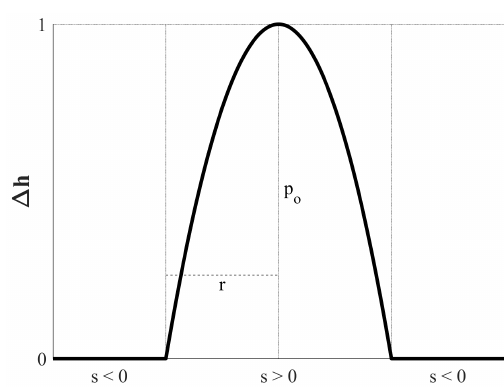
Figure 7. Graph of the height modifier